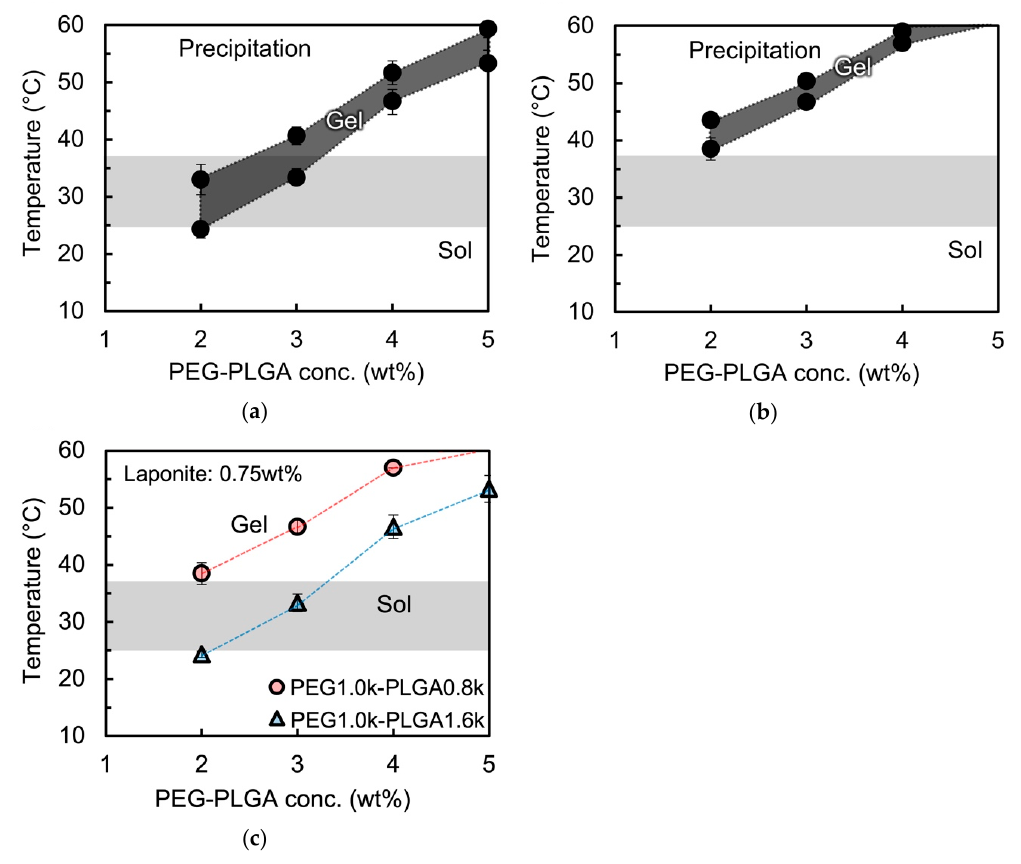
Figure 4. Thermo-responsive gelation behavior of the aqueous laponite/PEG–PLGA nanocomposites with ( a ) PEG1.0k–PLGA1.6k and ( b ) PEG1.0k–PLGA0.8k. The gelation temperatures ( T gel ) observed